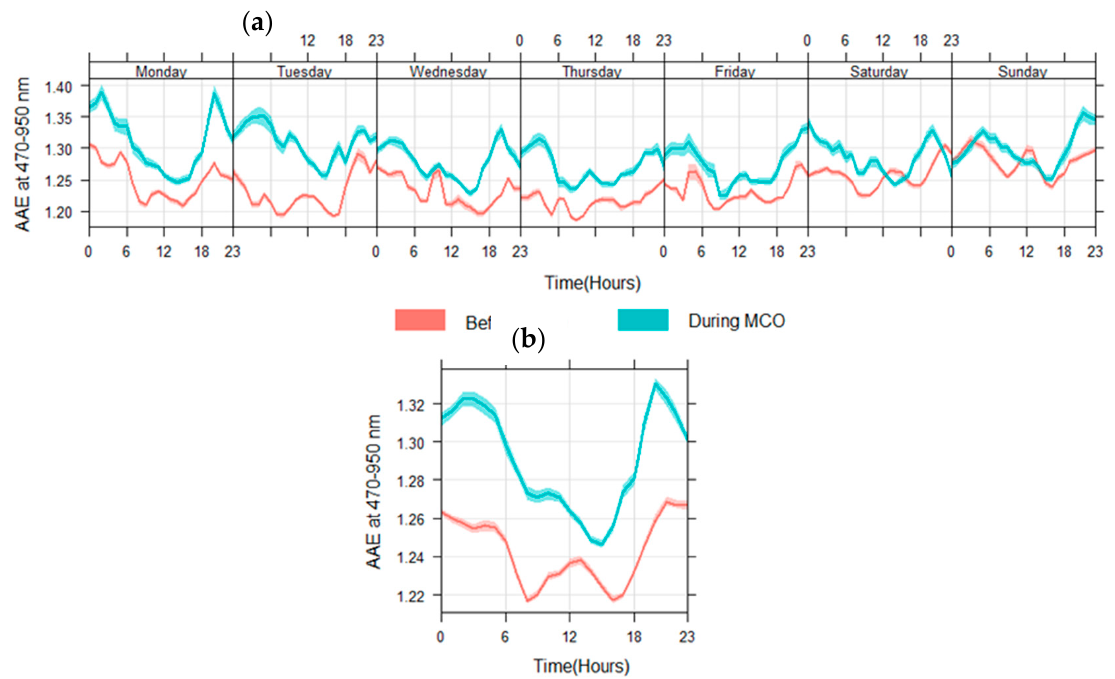
Figure 5. Mean diurnal variations of aerosol absorption Ångström exponent (AAE) derived from absorptions at 470 and 950 nm before (red line) and during (blue line) the movement control order (MCO) for ( a ) each day of the week and ( b ) all days together.